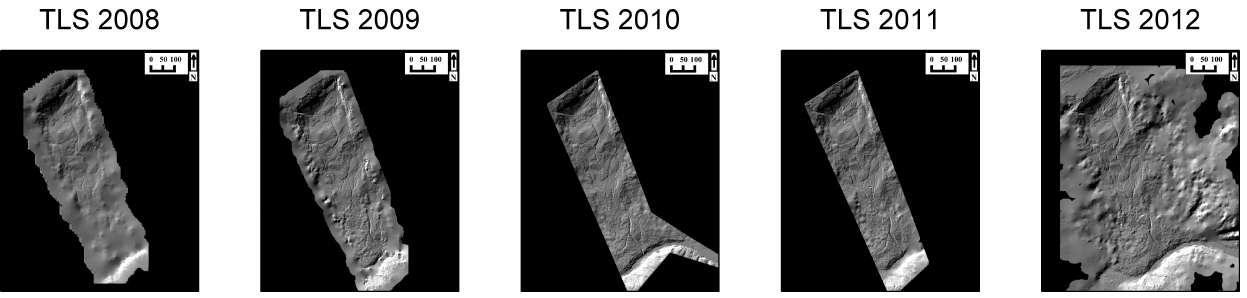
Figure 3. Shaded digital terrain models (DTMs) from terrestrial laser scanning (TLS) from 2008 to 2012. Left bottom and right top coordinates of the DTMs are [–34202, 5260749; –33387, 5261737]. The coordinate system is Austria Gauss-Kr¨uger M28 (MGI).